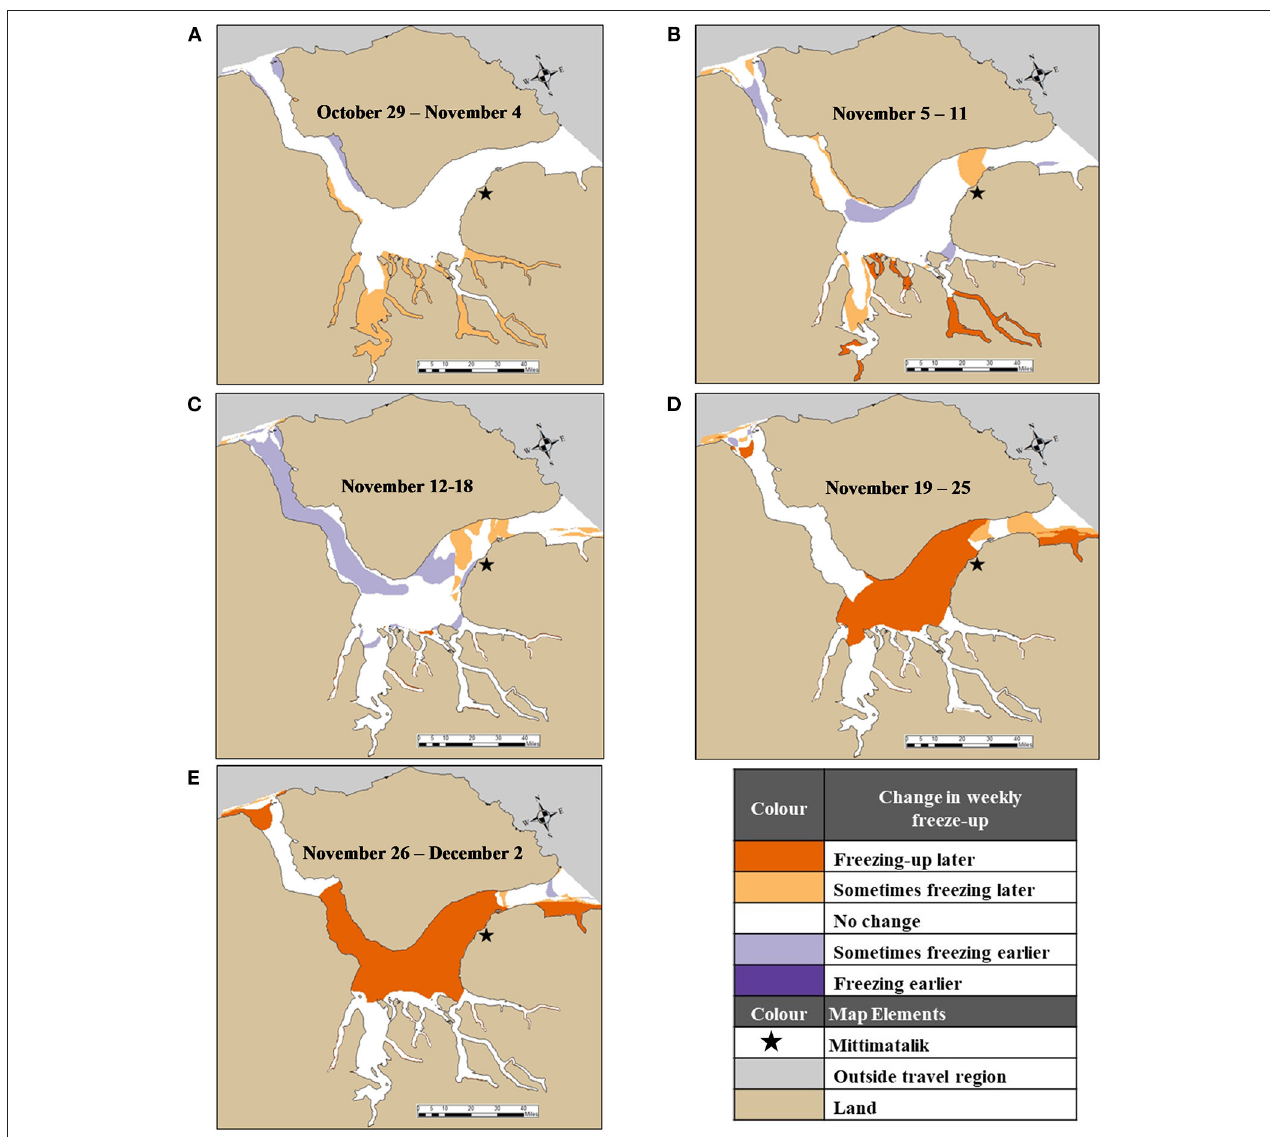
FIGURE 9 | Weekly difference maps showing areas where tuvaq is forming earlier or later in the last 10 years (2010–2019). (A) Difference map, October 29–November 4. (B) Difference map, November 5–11. (C) Difference map, November 12–18. (D) Difference map, November 19–25. (E) Difference map, November 26–December